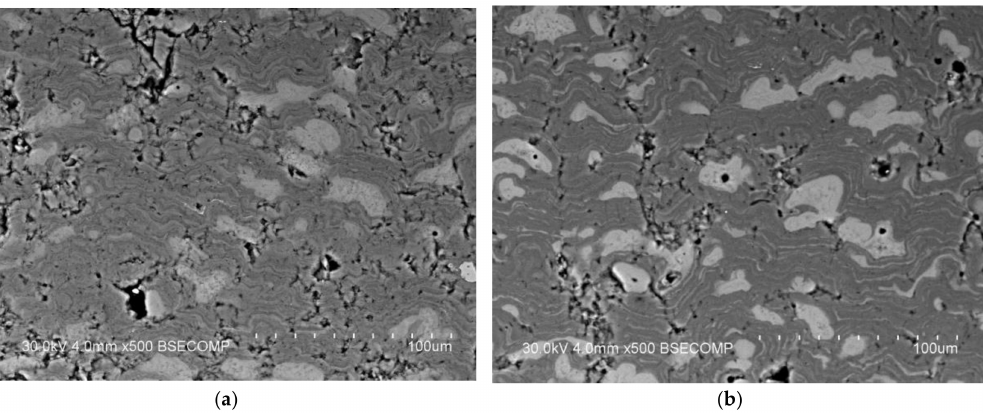
Figure 13. Cross-sections of the deposits obtained from titanium at an explosive charge of 30%, a spraying distance of 100 mm, k = 1.1 ( a ) and k = 2.5 ( b ) using air as a carrier gas (reprinted from [29], Copyright (2015), with permission from